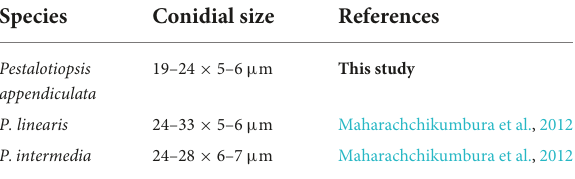
TABLE 2 Compare the conidia